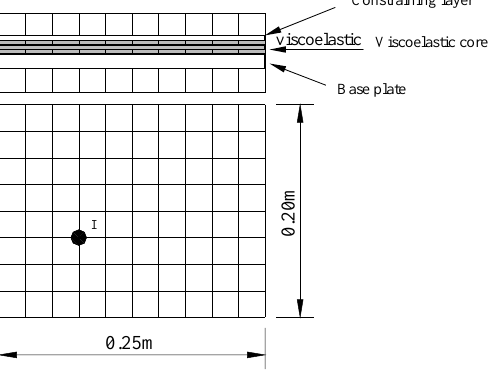
Fig. 4. Illustration of the FE model of a free plate with full surface treatment.